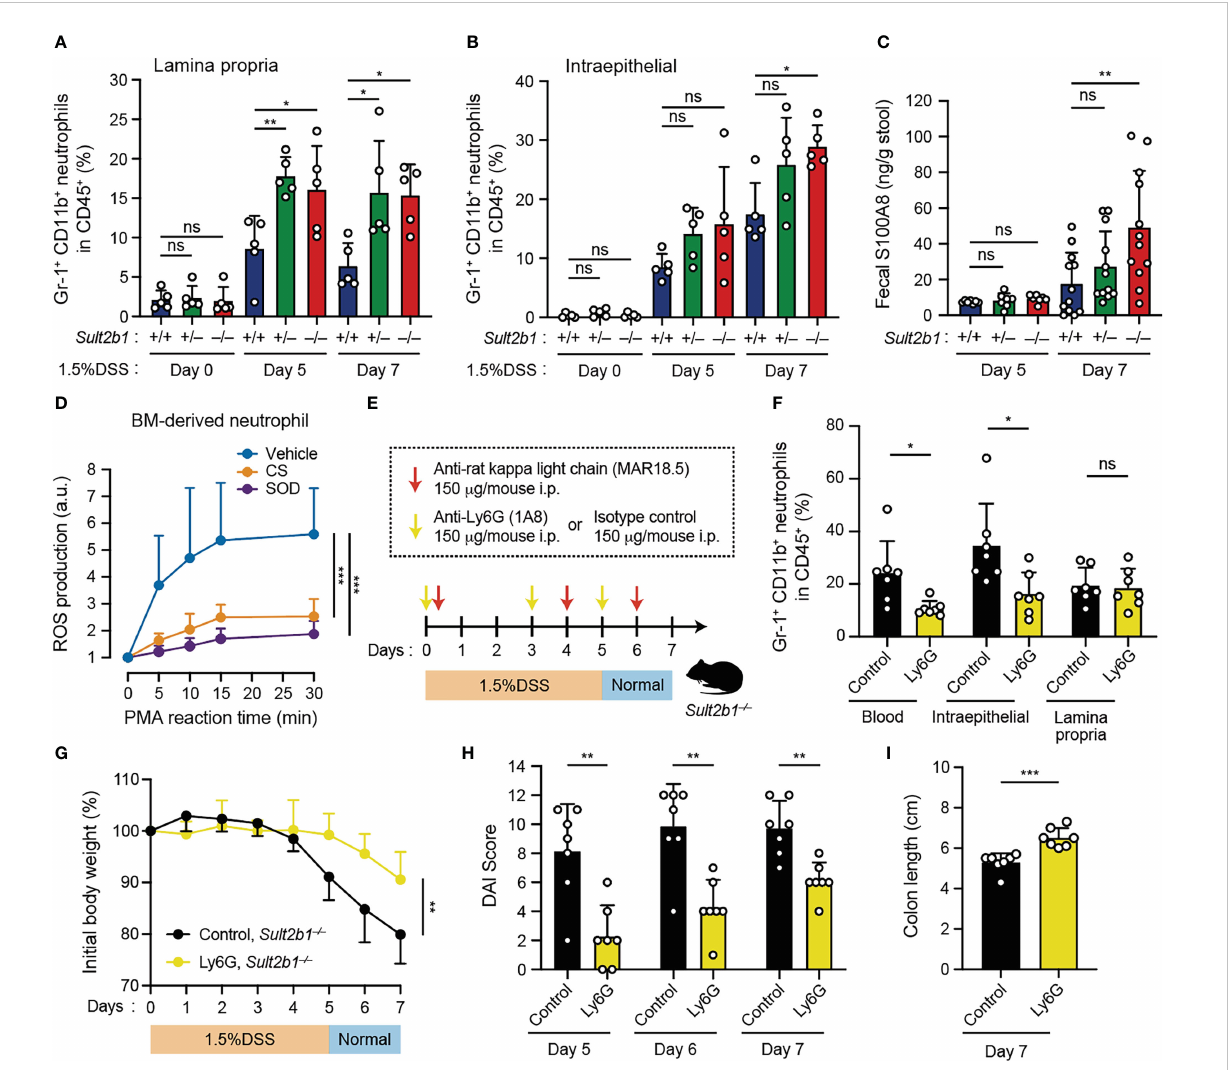
FIGURE 5 Depletion of circulating neutrophils leads to the alleviation of colitis in Sult2b1 − / − mice. (A, B) The percentage of CD11b + Gr-1 + neutrophils in lamina propria CD45 + cells or intraepithelial CD45 + cells in the colon from Sult2b1 +/+ , Sult2b1 +/ − , and Sult2b1 − / − mice (n = 5 mice per group; one-way ANOVA with Dunnett ’ s multiple comparison test). (C) Fecal concentrations of S100A8 in 1.5% DSS-treated mice on days 5 and 7 (n = 12 mice per group; one-way ANOVA with Dunnett ’ s multiple comparison test). (D) ROS production in wild-type bone marrow-derived neutrophils stimulated using PMA (100 nM). Data are presented as the ratio after normalization of the 0-min value to an arbitrary unit (a.u.) of 1 (n = 6 mice per group; one- way ANOVA with Dunnett ’ s multiple comparison test). (E) Schematic illustration of the protocol used for circulating neutrophil depletion. Indicated antibodies were intraperitoneally administrated to Sult2b1 − / − mice. (F) The percentage of CD11b + Gr-1 + neutrophils in CD45 + cells of the blood and the colon tissues from Sult2b1 − / − mice after antibody treatments (n = 7 mice per group; two-tailed unpaired Student ’ s t -test). (G-I) Body weights, DAI scores, and colon length of anti-Ly6G-treated or isotype control-treated Sult2b1 − / − mice (n = 7 mice per group; two-tailed unpaired Student ’ s t - test). Data were obtained from fi ve (A, B) and three (C-I) independent experiments, and graphs are shown as the mean ± SD. * P < 0.05; ** P < 0.01; *** P < 0.001; ns, not signi fi